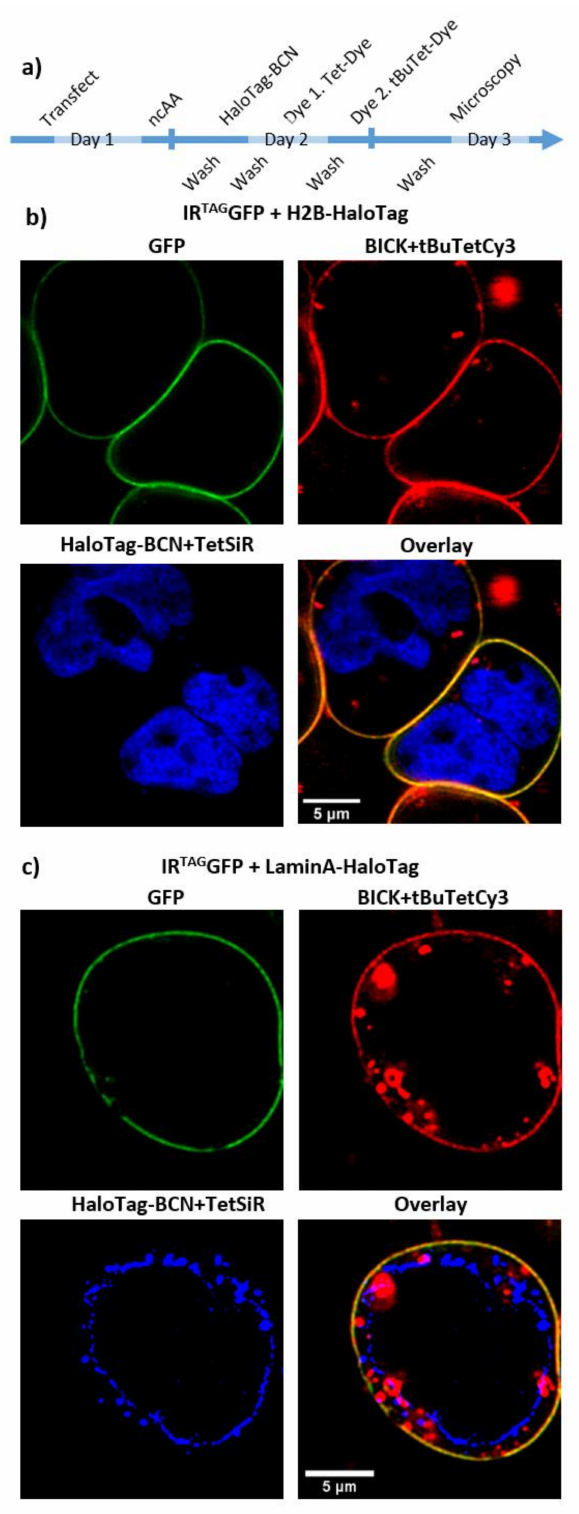
Figure 6. ( a ) Diagram representing the workflow for live cell dual-colour bioorthogonal labeling of overexpressed proteins in HEK293T cells combining incorporation of the ncAA BICK and the cycloaddition of a tertbutyl-tetrazine conjugated dye ( tBuTetCy3 ) and labeling through HaloTag-BCN with Tet-SiR . ( b , c ) Confocal images of dual-colour live cell labeling with the